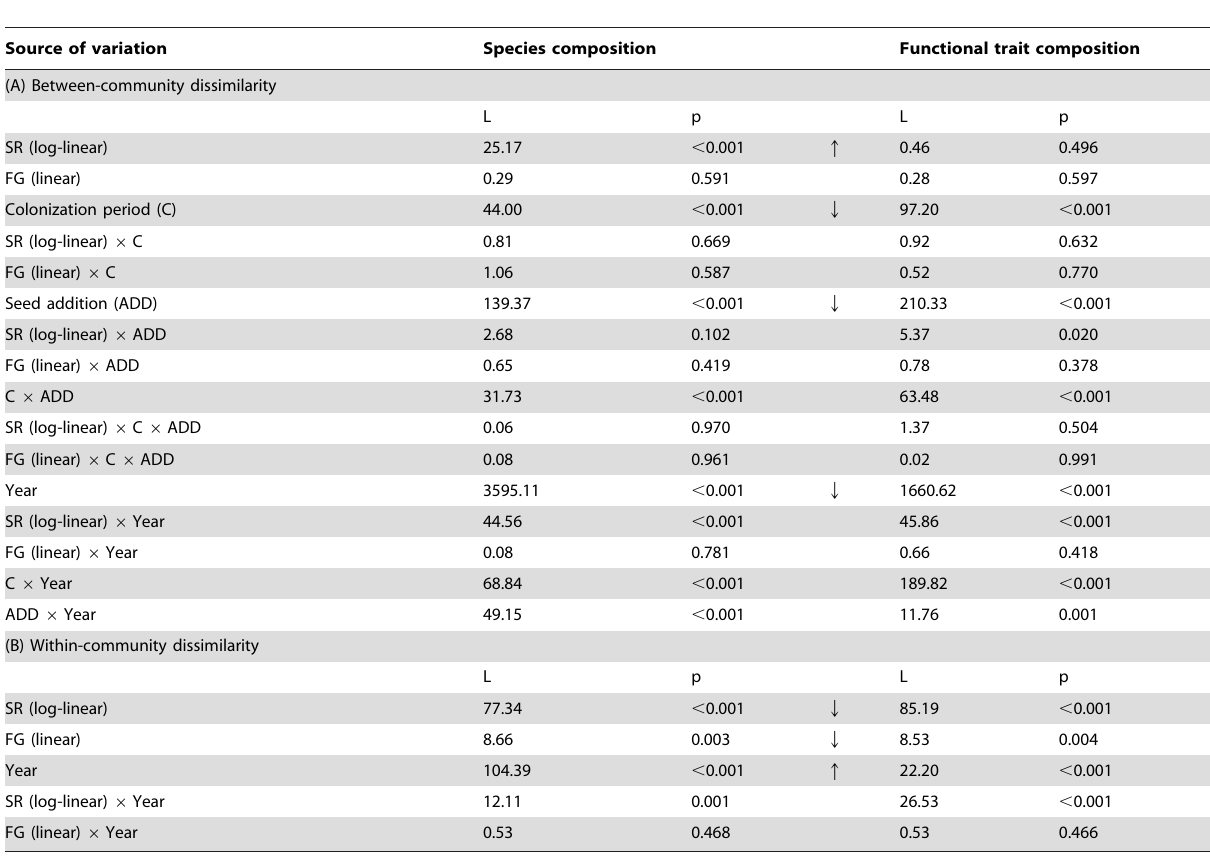
Table 3. Summary of mixed-effects model analyses for dissimilarity (Bray-Curtis distances) based on species composition and functional trait composition: (A) between-community dissimilarity per colonization period 6 seed addition treatment, (B) within- community dissimilarity across colonization period 6 seed addition treatments.